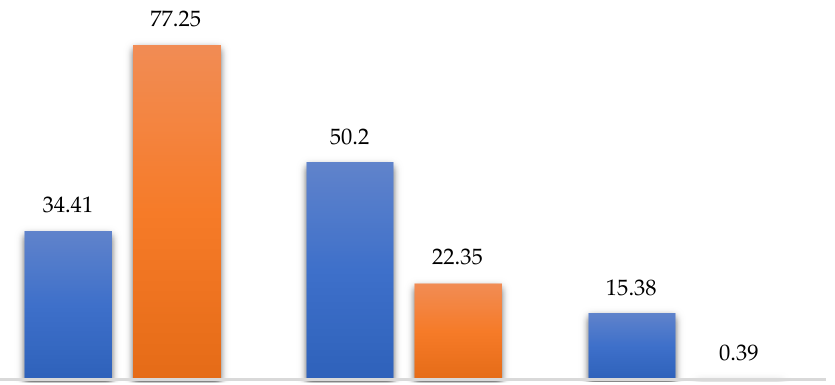
Figure 3. SQAS scores for social workers and clerics.